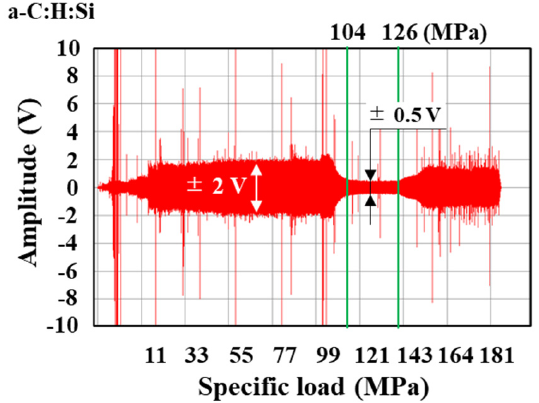
Figure 19. Relation between film parameter Λ and coefficient of friction µ .